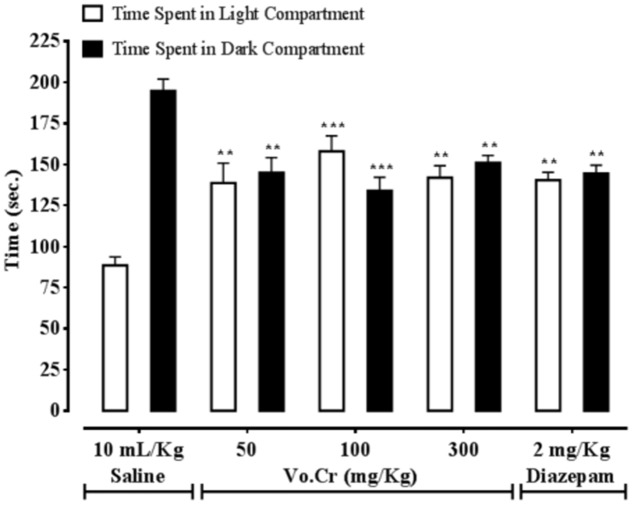
Bar-graph showing effects of Verbena officinalis crude extract (Vo.Cr) and diazepam on time spent by mice in light and dark compartments in light–dark box model. Data expressed as mean ± SEM, n = 4. ∗∗P < 0.01, ∗∗∗P < 0.001 vs. saline group, one-way ANOVA with post hoc Tukey test.